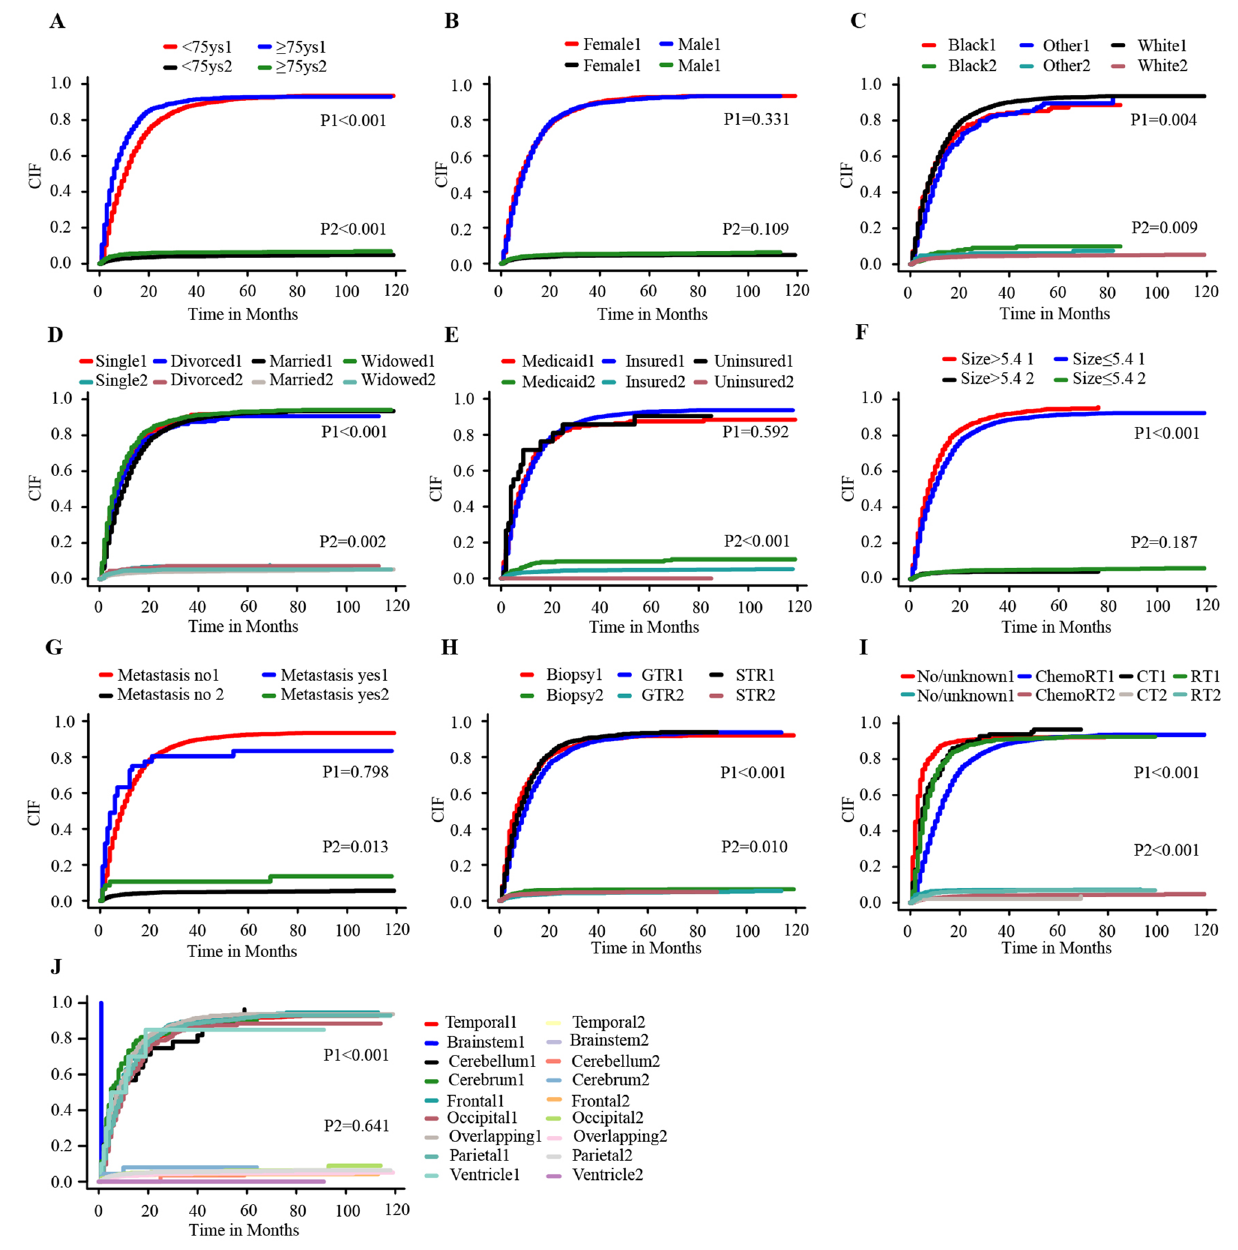
Figure 2. CIF curves for elderly with GBM by different variates. (A), Age group; (B), Sex; (C), Race; (D) , Marital status; (E) ,Insurance status; (F) , Tumor size; ( G ), Metastasis; ( H ),Surgery ( I ), Adjuvant therapy; ( J ), Primary site. Note : P1 represents the difference of GBM related death. P2 represents the difference of non-GBM related